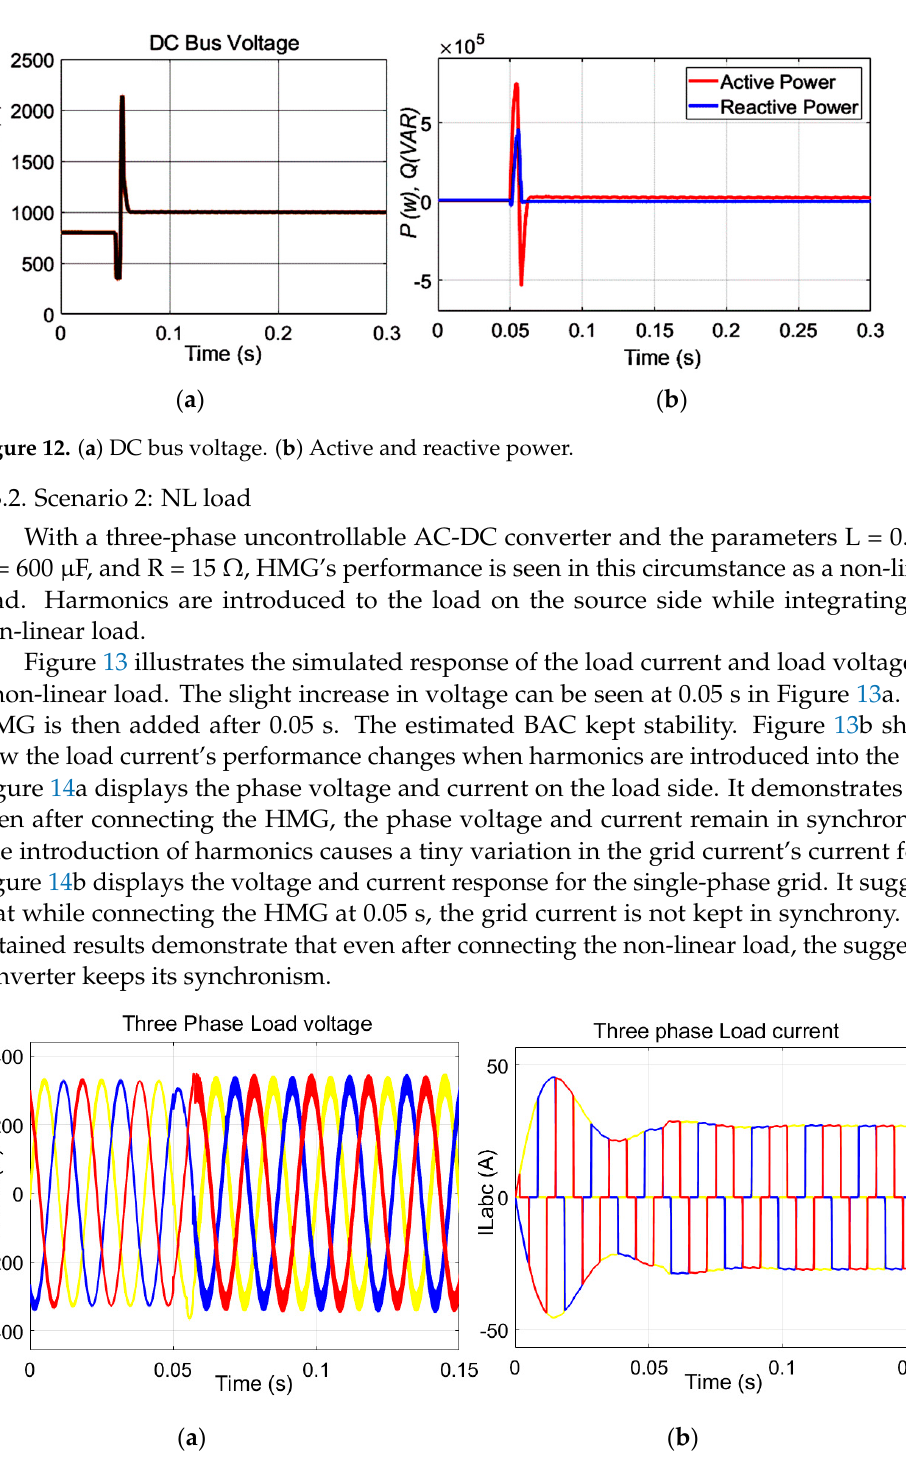
( b ) Figure 11. ( a ) Phase voltage and current of grid. ( b ) Load voltage and current. The described method’s DC link voltage waveform, where the input is powered by sun, wind, and hydrogen, is shown in Figure 12a. It maintains a steady 1000 V DC from 0.065 s after joining the HMG. Figure 12b depicts the reaction of the grid’s active and re- active power both before and after the addition of the microgrid to the common bus. The